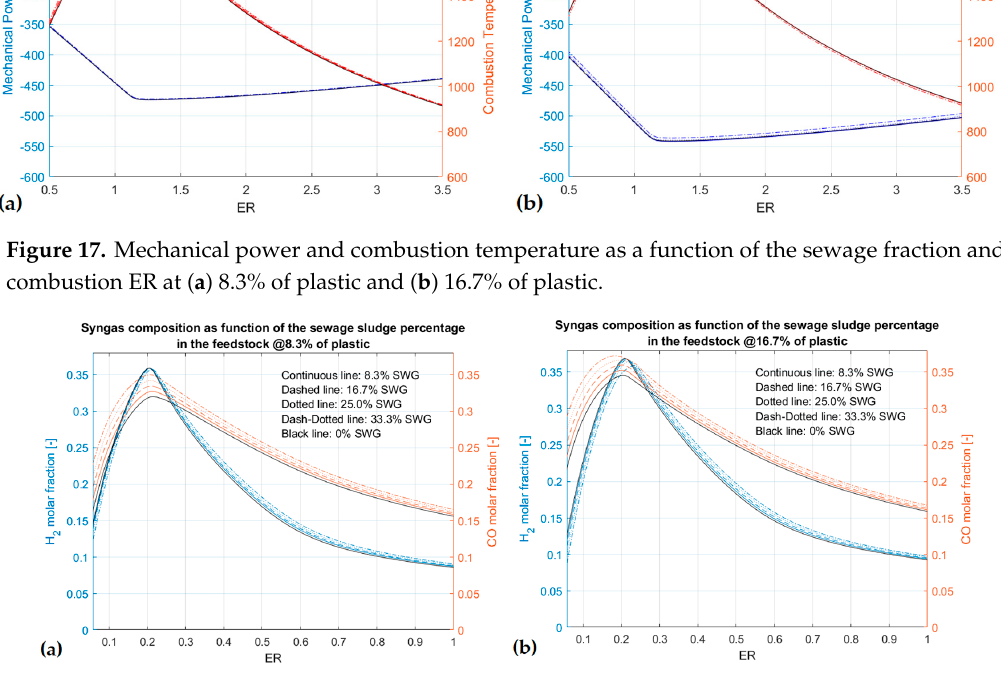
Figure 18. H 2 and CO molar fractions as a function of sewage fraction and gasification ER at ( a ) 8.3% of plastic and ( b ) 16.7% of plastic.